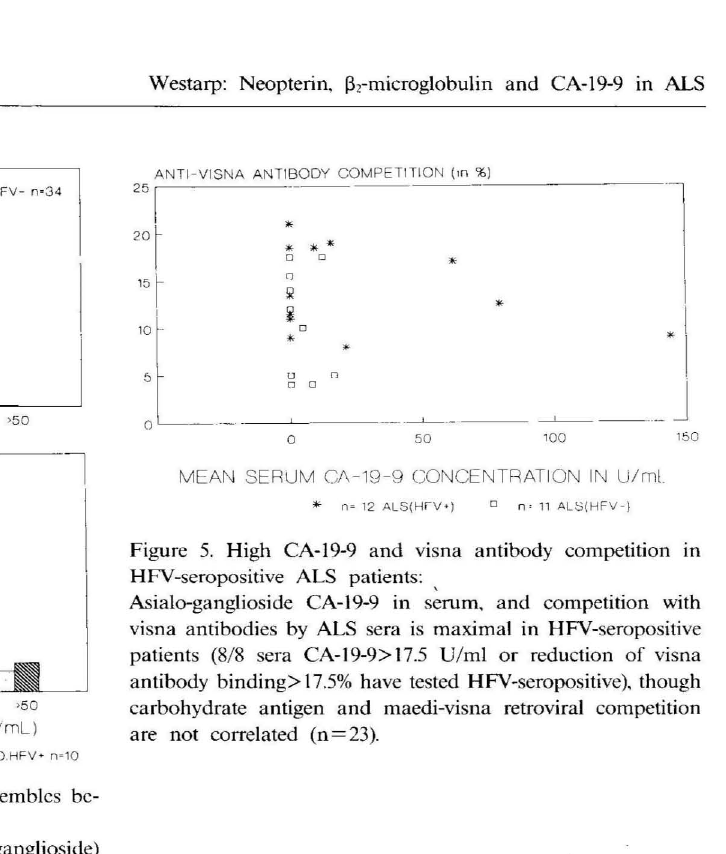
Figure 4. CA-19-9 in HFY-seropositive patients resembles be nign gastro-intestinal disease: Distribution of carbohydrate antigen 19-9 (asialo-ganglioside) in serum of 34 HFY-antibody negative ALS, 26 HFY-antibody posotive ALS, and 10 anti-HFY antibody positive other neuro logical patients, compared to published controls (26)